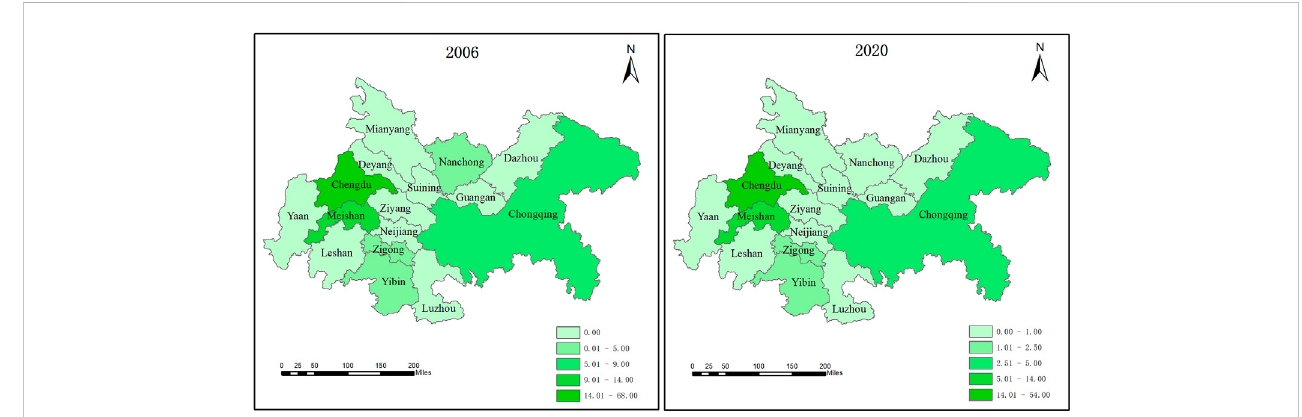
FIGURE 6 The betweenness centrality of 2006 and 2020 in Chengdu-Chongqing urban agglomeration.